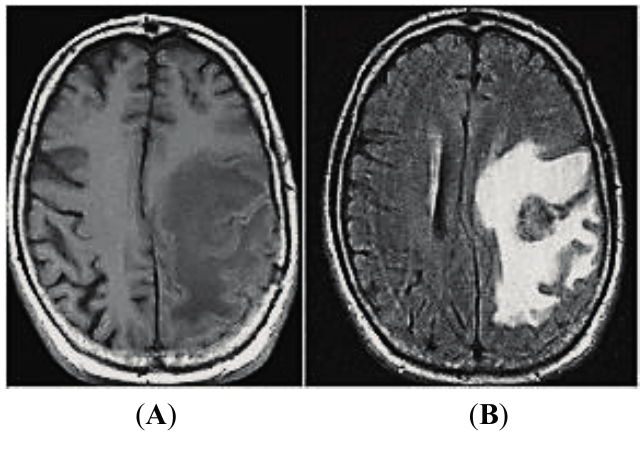
Figure 2. MRI of the brain to illustrate loss of blood–brain barrier integrity. Patient with metastatic brain lesion in the left cerebral hemisphere ( A ) before contrast; ( B ) after contrast. The leakage of contrast material (gadolinium) into and around the tumor rules out the blood–brain barrier as the sole mechanism for drug